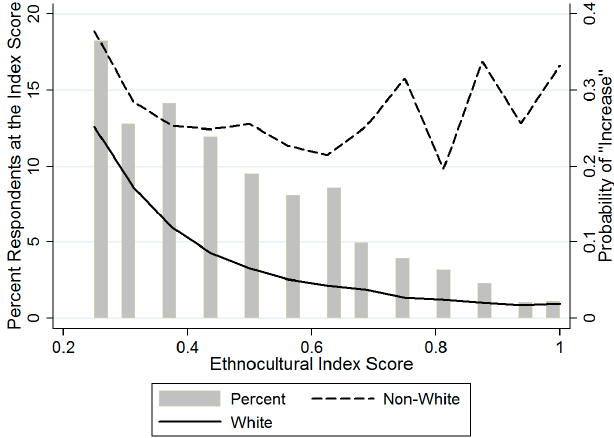
Figure 6. Predicted probability of “increase” response by race and ethnocultural index score.